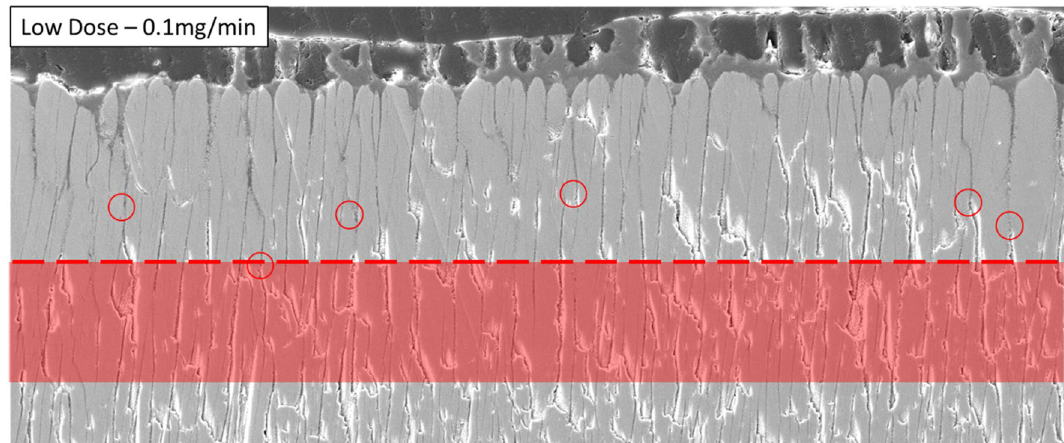
Fig. 3 Cross-section of low deposition rate condition (0.1 mg/min) with several CMAS freeze locations circled in red. Dotted line indicates initial theoretical freeze line. Translucent band indicates potential movement of freeze line with CMAS infiltration